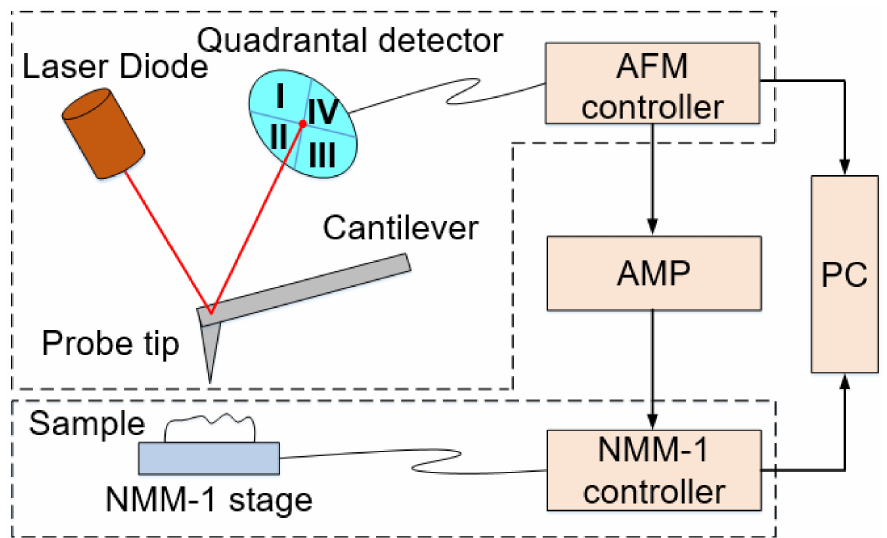
Figure 3. Schematic diagram of the AFM system.